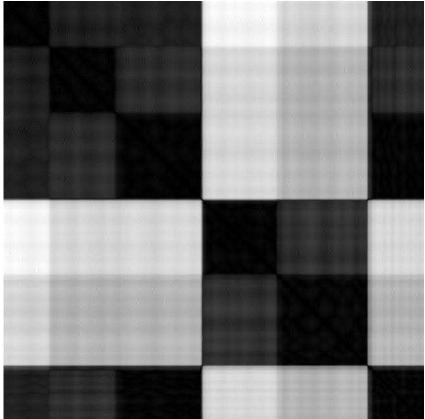
Figure 2 . Image of time indexed matrix of 2-point com- binatorial distances img ( D